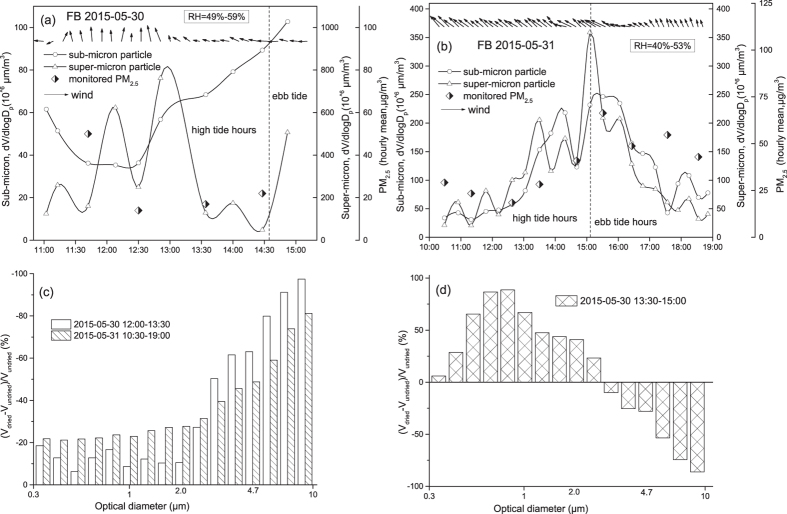
The volume concentrations of sub- and super-micron particles in relation to tide, wind and PM2.5, (a): the 2015-05-30 samples, under onshore wind during 11:00–13:00 while offshore wind during 13:00–15:00; (b): the 2015-05-31 samples, during 10:00–19:00 under dominant onshore wind. (c,d): the percentages of (Vdried − Vundried)/Vundried.